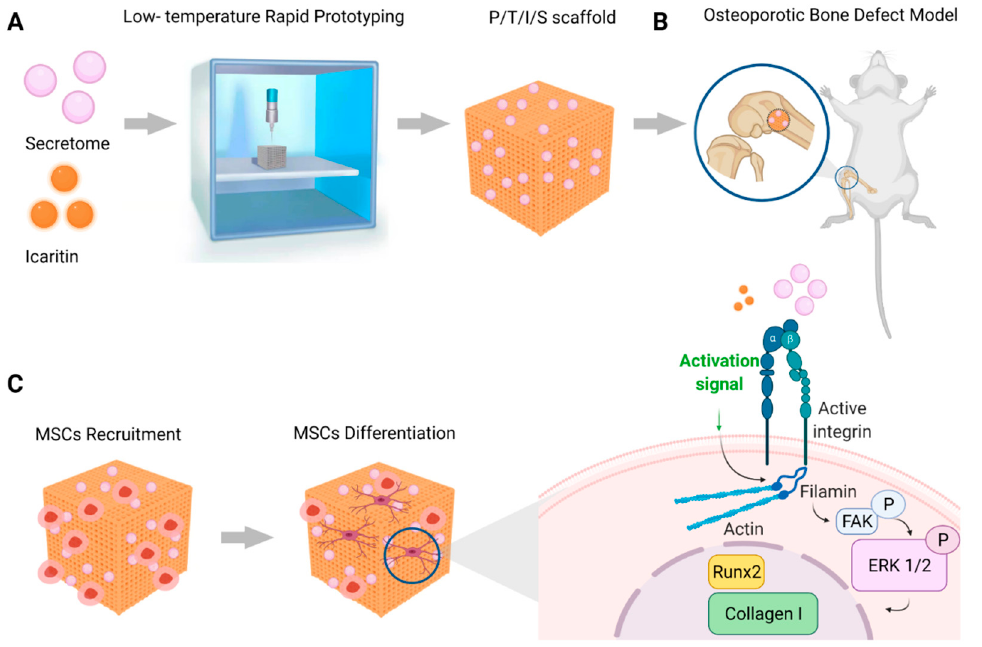
Scheme 1. Schematic illustration of the fabrication of the bioactive porous scaffold and its applica- tion in osteoporotic bone regeneration. ( A ) The preparation of the P/T/I/S scaffold. ( B ) The applica- tion of the scaffold in osteoporotic bone defect healing. ( C ) The proposed underlying